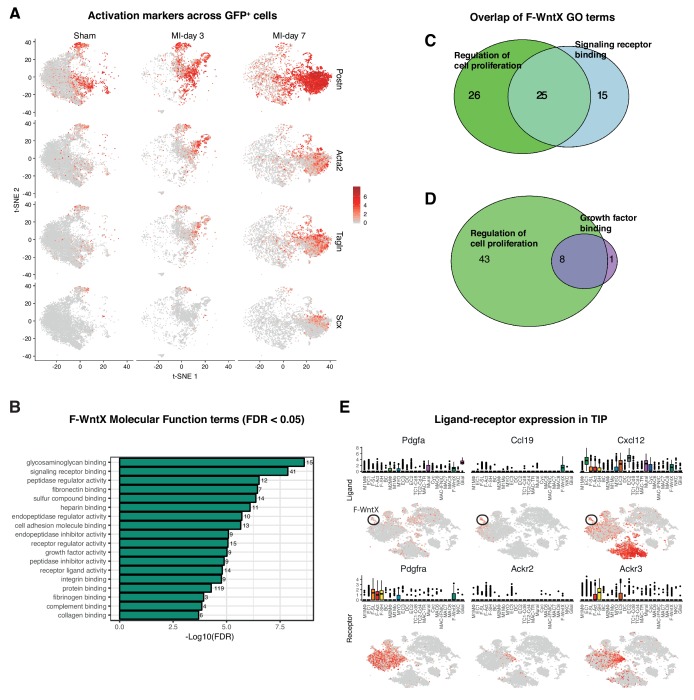
Activation and paracrine signature of F-WntX cells.(A) Expression of markers of activation visualized on condition-specific t-SNE plots. (B) GO Molecular Function terms over-represented (FDR < 0.05) in genes upregulated in F-WntX compared to F-SL/F-SH. (C, D) Venn diagram of overlap between F-WntX marker genes in ‘Regulation of cell proliferation’ category and MF categories ‘Signaling receptor binding’ (C) and ‘Growth factor binding’ (D). (E) Examples of ligands upregulated in F-WntX and corresponding receptors as expressed in TIP and visualized in box and t-SNE plots. For each ligand the corresponding receptor is immediately below. Circle indicates the location of F-WntX on the t-SNE plot.